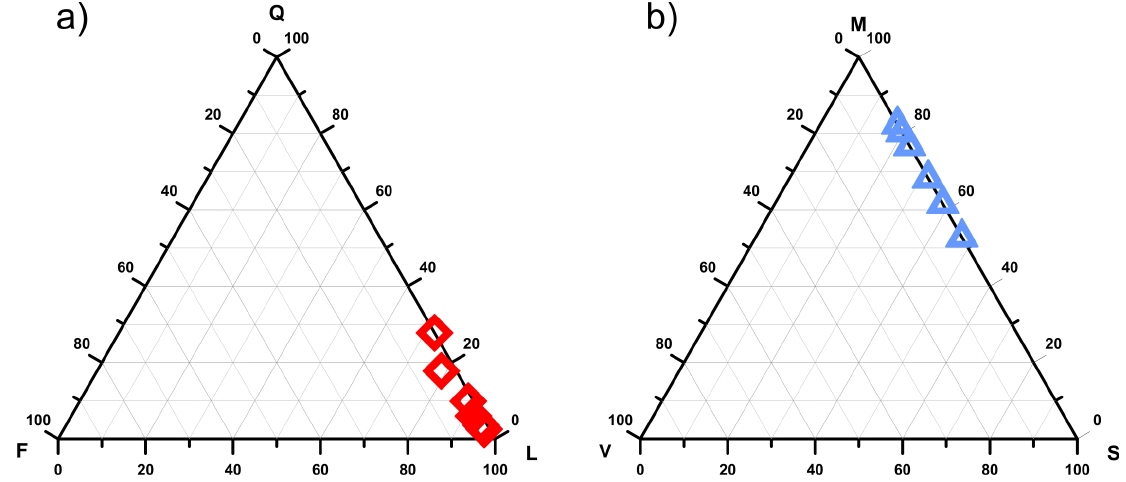
Figure 3. ( a ) Quartz-Feldspar-Lithic plot summarizing the sample compositions [45]. ( b ) Ternary diagram Metamorphic-Volcanic-Sedimentary of the lithic grains in the analyzed samples: notable is the presence of grains of sedimentary origin.